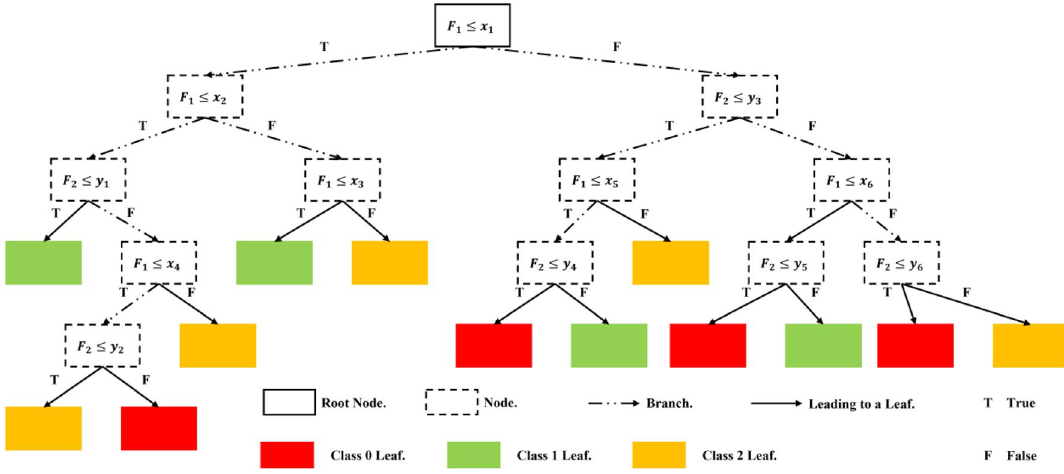
Figure 5. DTC example